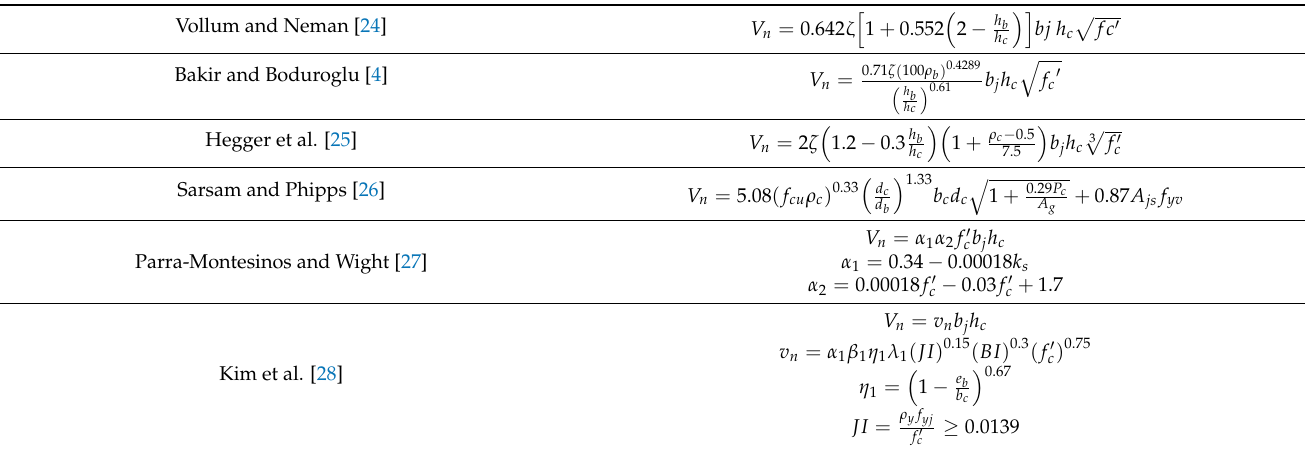
Table A1. Previously Proposed Model for RC Exterior